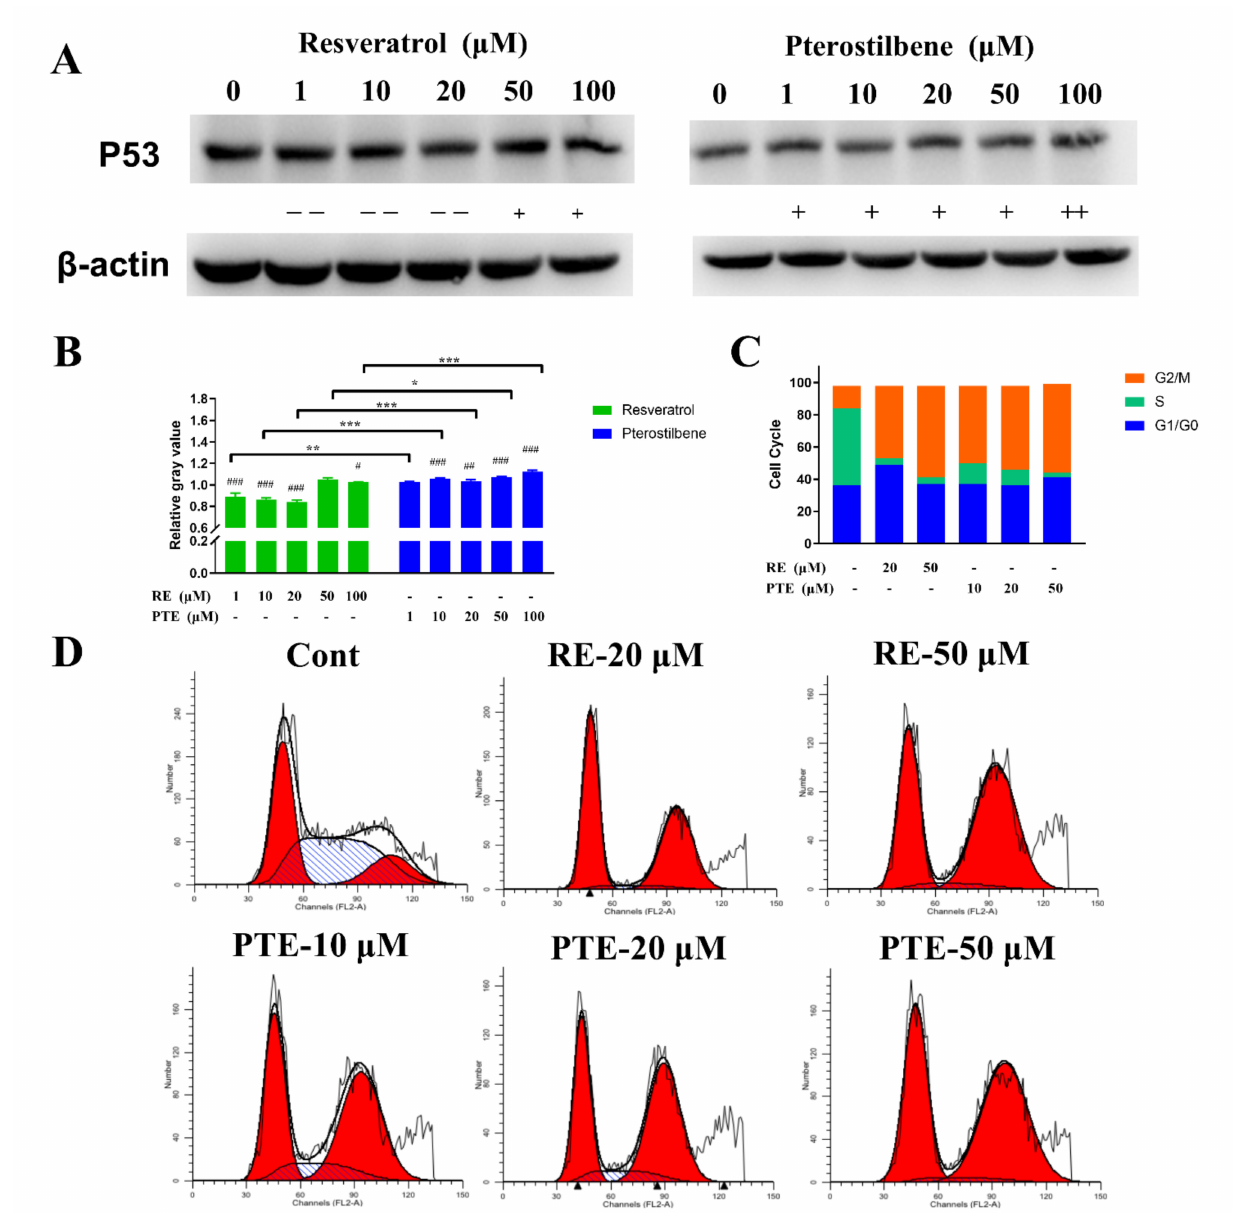
Figure 3. ( A ) WB probing for P53 in CL 187 cells treated with PTE and RE for 12 h. Loading was normalized based on the level of the internal control, β -actin. Compared with the control group, “+” or “ − ” was denoted when the change of gray value was between 0 and 10%, “++” or “ − − ” was denoted when the change of gray value was between 10–20%. ( B ) Gray value analysis of WB experiment results. * p < 0.05, ** p < 0.01, and *** p < 0.001 vs. RE treatment group. # p < 0.05, ## p < 0.01 and ### p < 0.001 vs. control group. ns, not significant. Data are mean ± SD, n = 3. ( C ) The percentage of cells that stay in different replication cycles. ( D ) RE and PTE arrested cell cycle at G2/M phase. CL 187 cells exposed to PTE or RE for 48 h were examined by flow cytometry